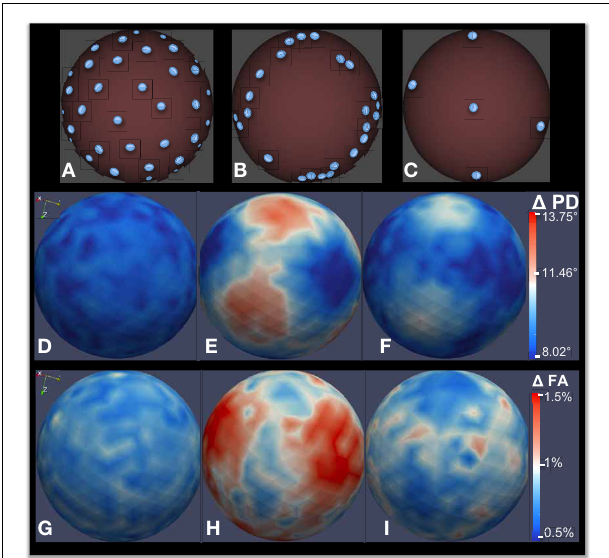
FIGURE 7 | Bias analysis of different DWI schemes via MC simulation. (A–C) Gradient direction distribution for three common DWI acquisition schemes: 42-direction quasi-uniform, Phillips 32-direction non-uniform, and 6-direction uniform. (D–F) Estimated error distribution in PD computation. (G–I) Estimated error distribution in FA computation as a percentage of true FA. 200,000 MC simulation were performed for this experiment, with a true FA value of 0.4 and SNR =